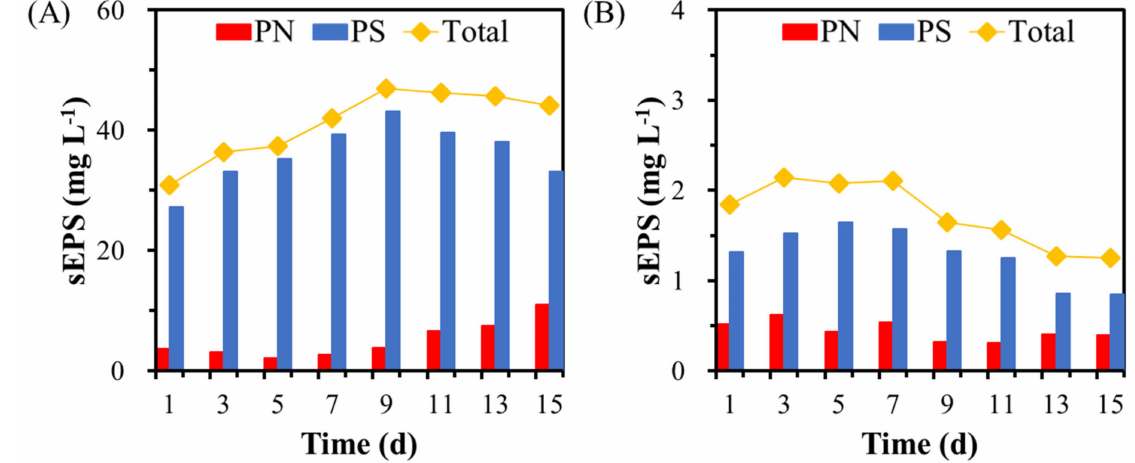
Figure 9. sEPS concentration in the GMBR mixed liquor ( A ) and membrane effluent ( B ) within a backwash cycle.